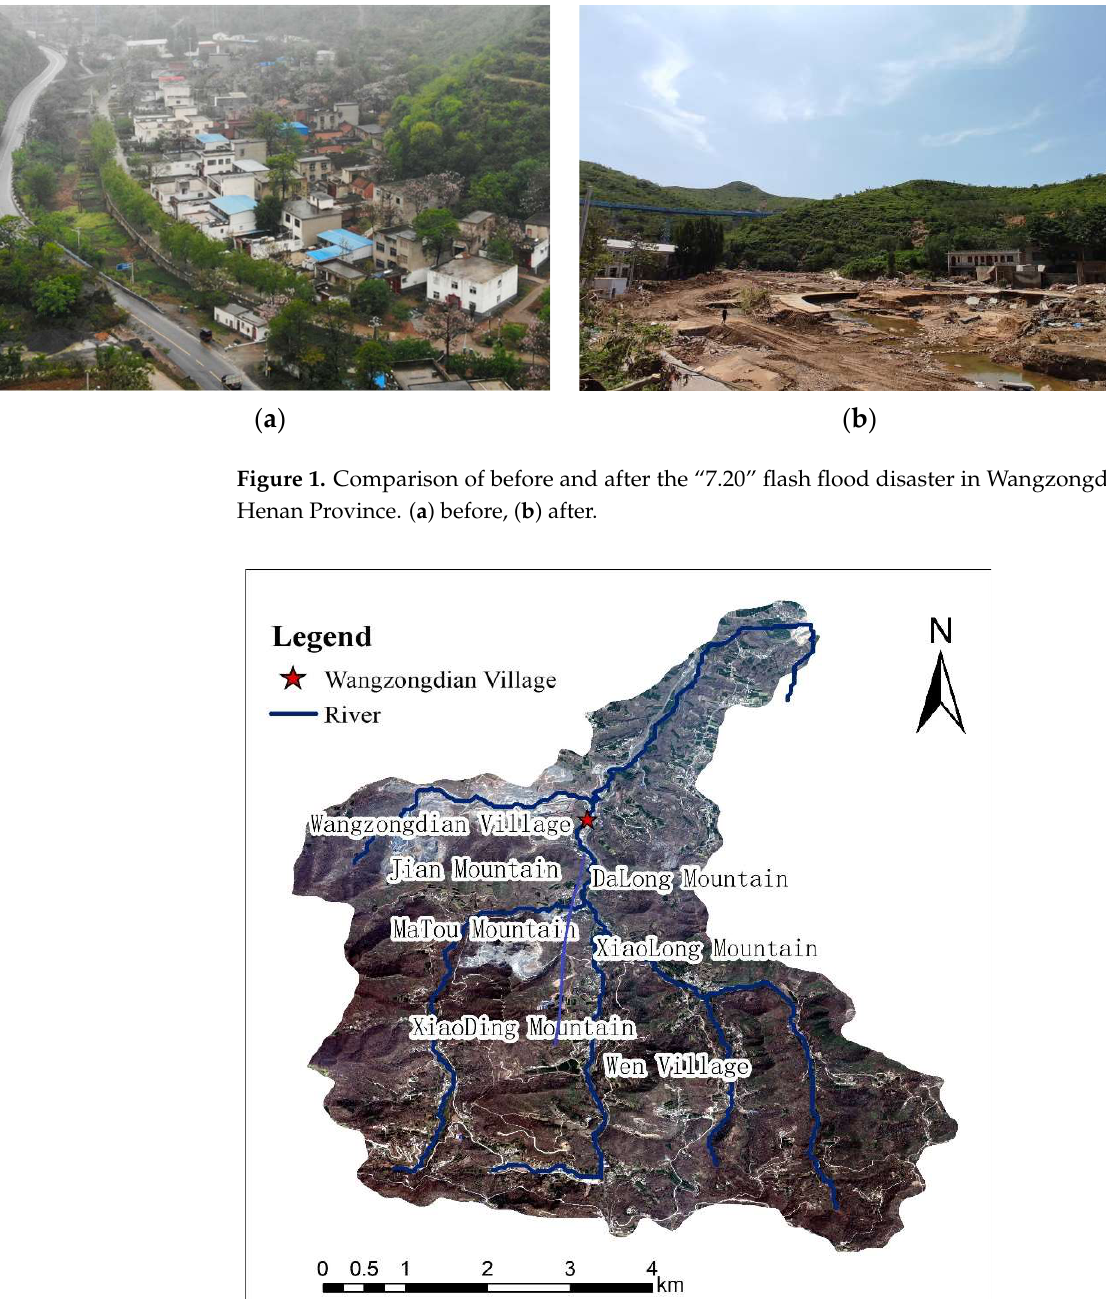
Figure 1. Comparison of before and after the “7.20” flash flood disaster in Wangzongdian Village, Henan Province. ( a ) before, ( b ) after.